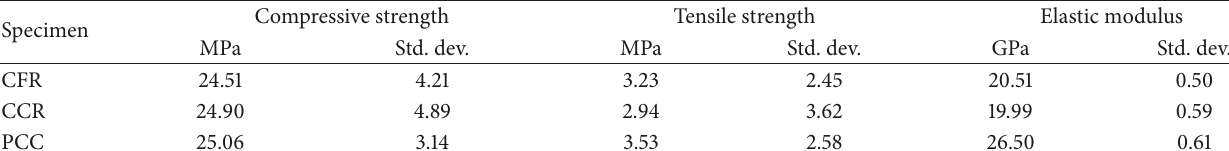
Table 2: Elastic properties.